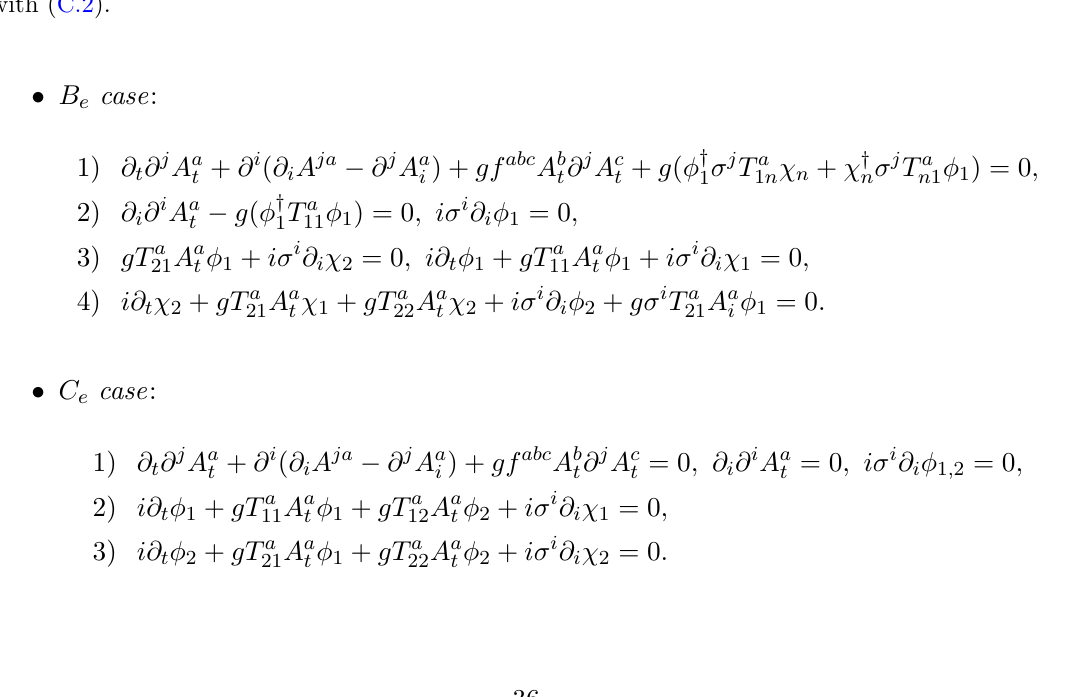
Table 1. Scaling of spinors in EEE sector: [1{3] satisfy (cid:12) 1 ; 2 (cid:0) (cid:11) 1 ; 2 = 1; [4{9] satisfy (cid:12) 1 (cid:0) (cid:11) 1 = 1 and (cid:11) 2 (cid:0) (cid:12) 2 = 1; [10{12] satisfy (cid:11) 1 ; 2 (cid:0) (cid:12) 1 ; 2 = 1; [13{18] satisfy (cid:11) 1 (cid:0) (cid:12) 1 = 1 and (cid:12) 2 (cid:0) (cid:11) 2 = 1 along with